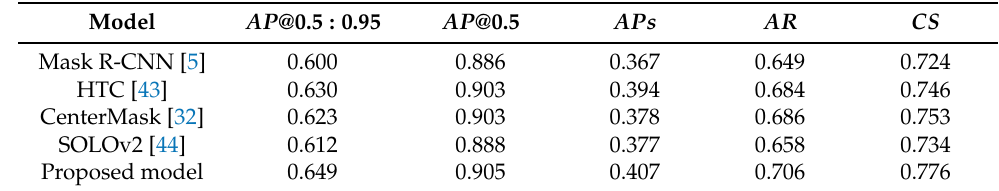
Table 2. Comparison of different network extraction methods on CrowdAI. The best results are highlighted in bold.